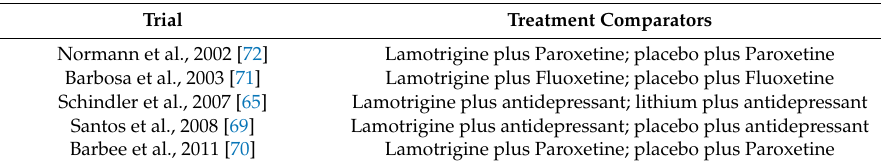
Table 7. List of Included Lamotrigine